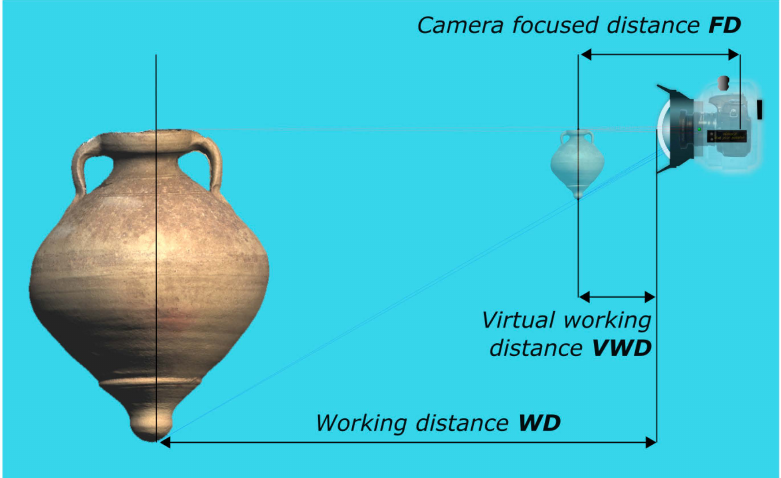
Figure 5. Effect of a dome port: a subject located at a working distance (WD) appears smaller and much closer to the camera—virtual working distance